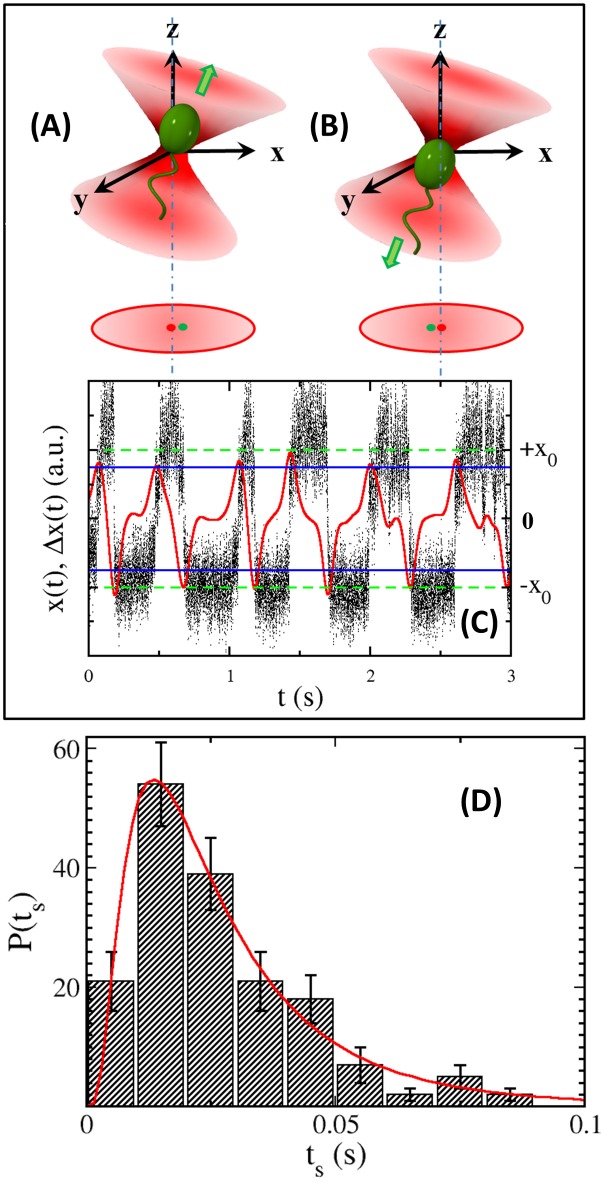
Optical trapping and swimming interval measurements.(A) depicts a forward swimming bacterium trapped at the rear end of the cell body whereas (B) depicts a backward swimming bacterium trapped at the front end of the cell body. In both (A, B), the green arrows indicate the swimming direction of the cell. This results in a shift in the center of mass of the cell in the optical trap, where the dot-dash lines and the red dots indicate the center of the optical trap. By slightly tilting the optical trap, the center of mass location of the cell body has a small projection (the green dots) along the x-axis of PSD. As the cell swims back and forth, its x position fluctuates as depicted by the small black dots in (C). There are two stable positions, +x
0 and −x
0, corresponding to bacterial forward and backward swimming, and they are delineated by the green dashed lines. The red curve represents convoluted time trace Δx(t), and the blue solid lines indicate the thresholds. (D) The histogram shows the transition-time distribution P(t
s). The red line is the fitting to the log-normal distribution with the mean μ
u ≃ −3.8 and the standard deviation σ
u ≃ 0.72.